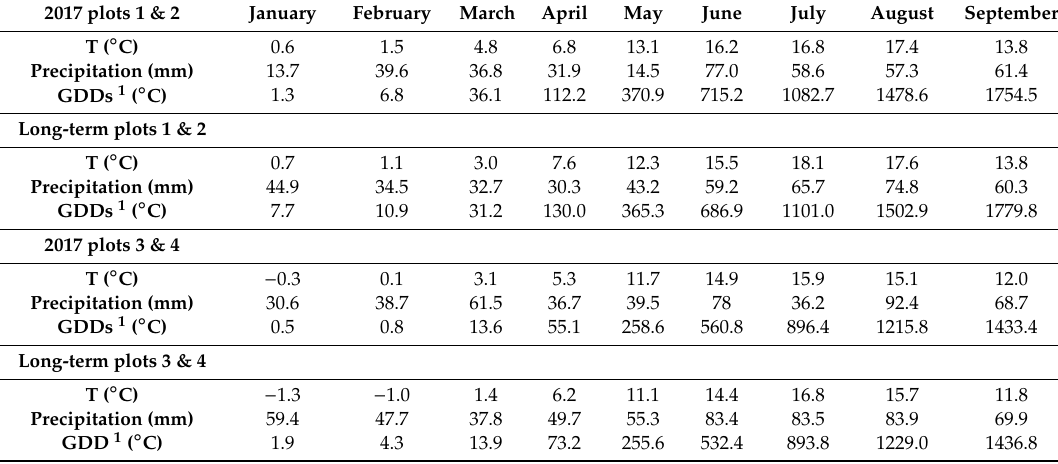
Table 3. The average ambient T ( ◦ C), average precipitation (mm) and mean values of growing degree days (GDDs, ◦ C) for each month in 2017. The long-term means for T and GDD were calculated between 1987 and 2016 for all plots. The long-term precipitation for plots 1 and 2 was calculated between 1987 and 2016, but between 1992 and 2016 for plots 3 and 4. The temperature was recorded in Lund, and the precipitation in Landskrona, for plots 1 and 2. For plots 3 and 4, the T from Gendalen and precipitation from Trökörna have been